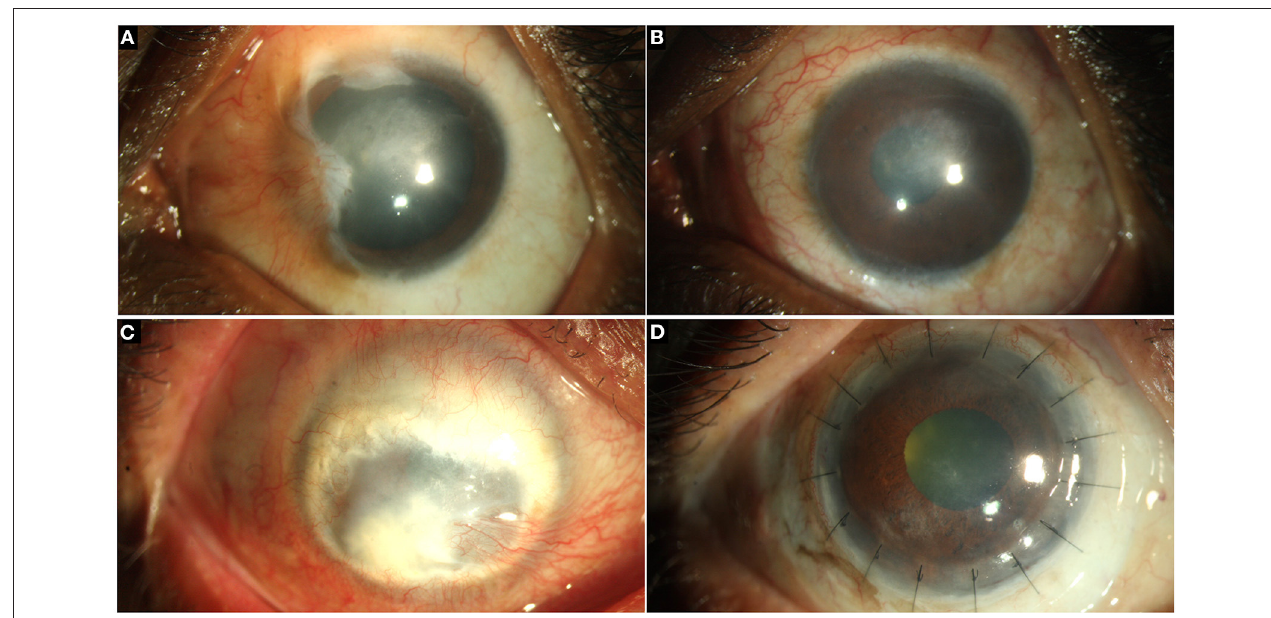
FIGURE 5 | (A) Partial limbal stem cell deficiency (LSCD) following chemical injury managed with conjunctival limbal autograft (CLAu). (B) Restoration of a stable ocular surface is noted. (C) Total LSCD with leucomatous corneal scarring. (D) Reestablishment of an optically clear visual axis and a stable corneal epithelium with deep anterior lamellar keratoplasty and